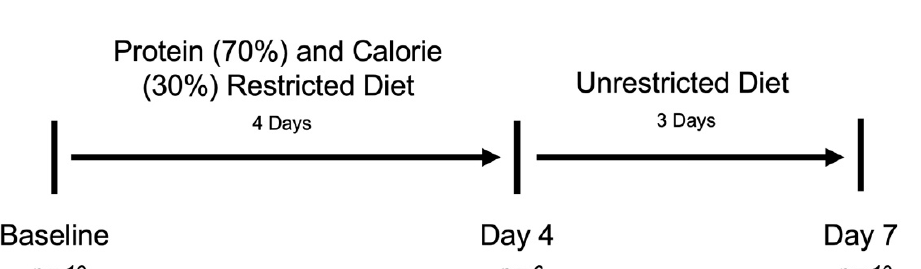
Figure 1. Study Timeline. Ten participants followed a four-day, calorie and protein restriction